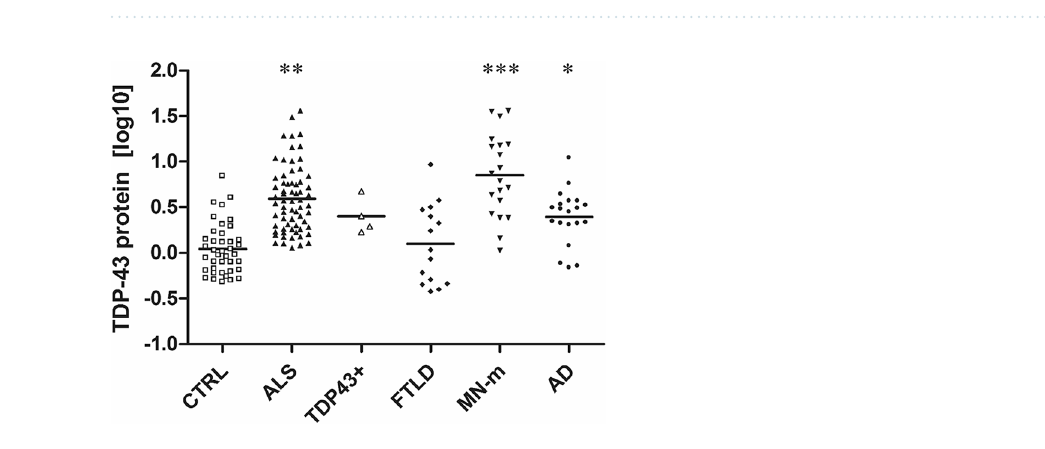
one may point out the fact that MN-m displayed a strong dissociation between NAb and protein levels. Further